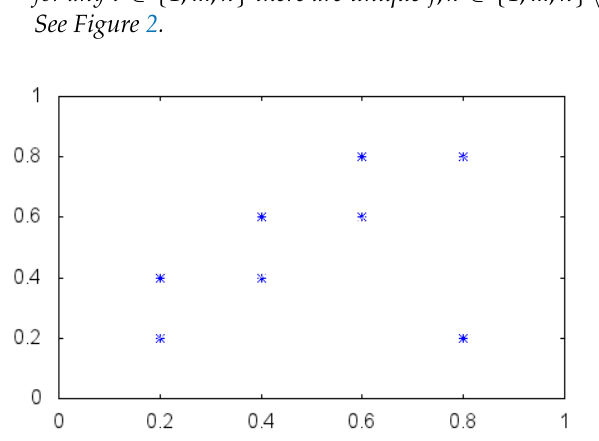
Figure 2. An even number n of points, n ≥ 4, following the distribution stated in Case (2) of Theorem